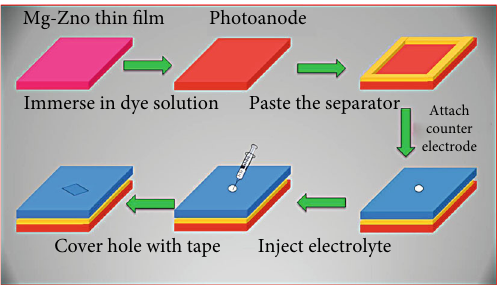
Figure 1: Schematic of the fabrication of DSSC using Mg-doped ZnO photoanode and fruit extract of Rhodomyrtus tomentosa